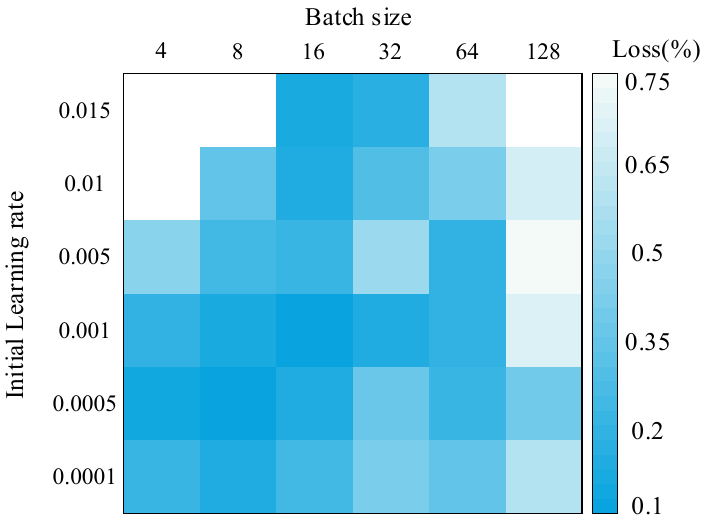
Figure 6. The flowchart of proposed SOH estimation algorithm.